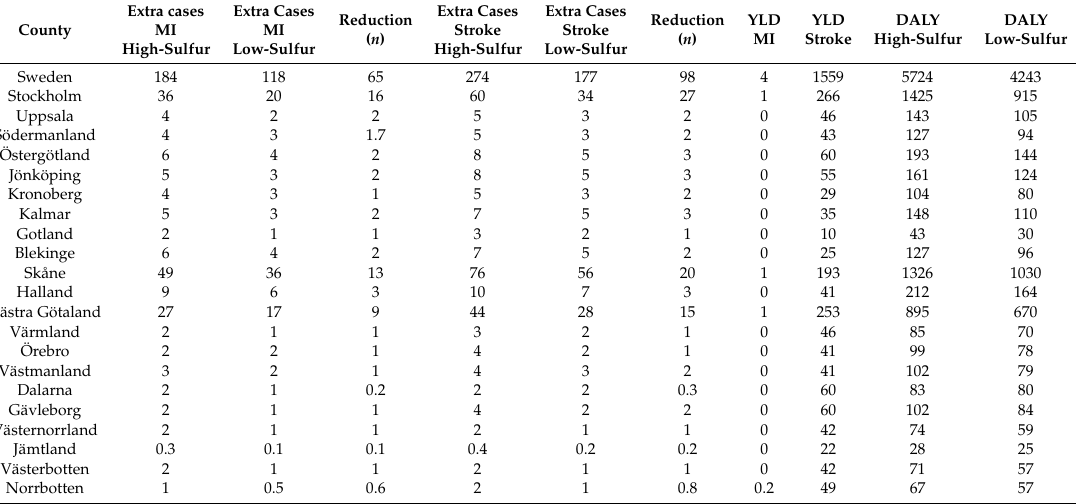
Table 4. Estimated number of extra annual cases of myocardial infarction and stroke due to PM 2.5 emissions from Baltic shipping at the regional model in the high- and low-sulfur